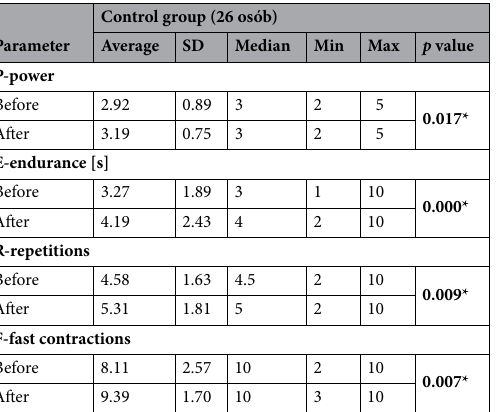
Table 6. PFM assessment results based on Perfect test in the control group. Values statistically significant are in bold. *Wilcoxon test.